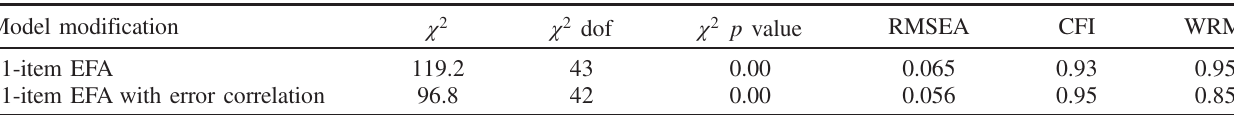
TABLE X. Impact of modifications on global fit